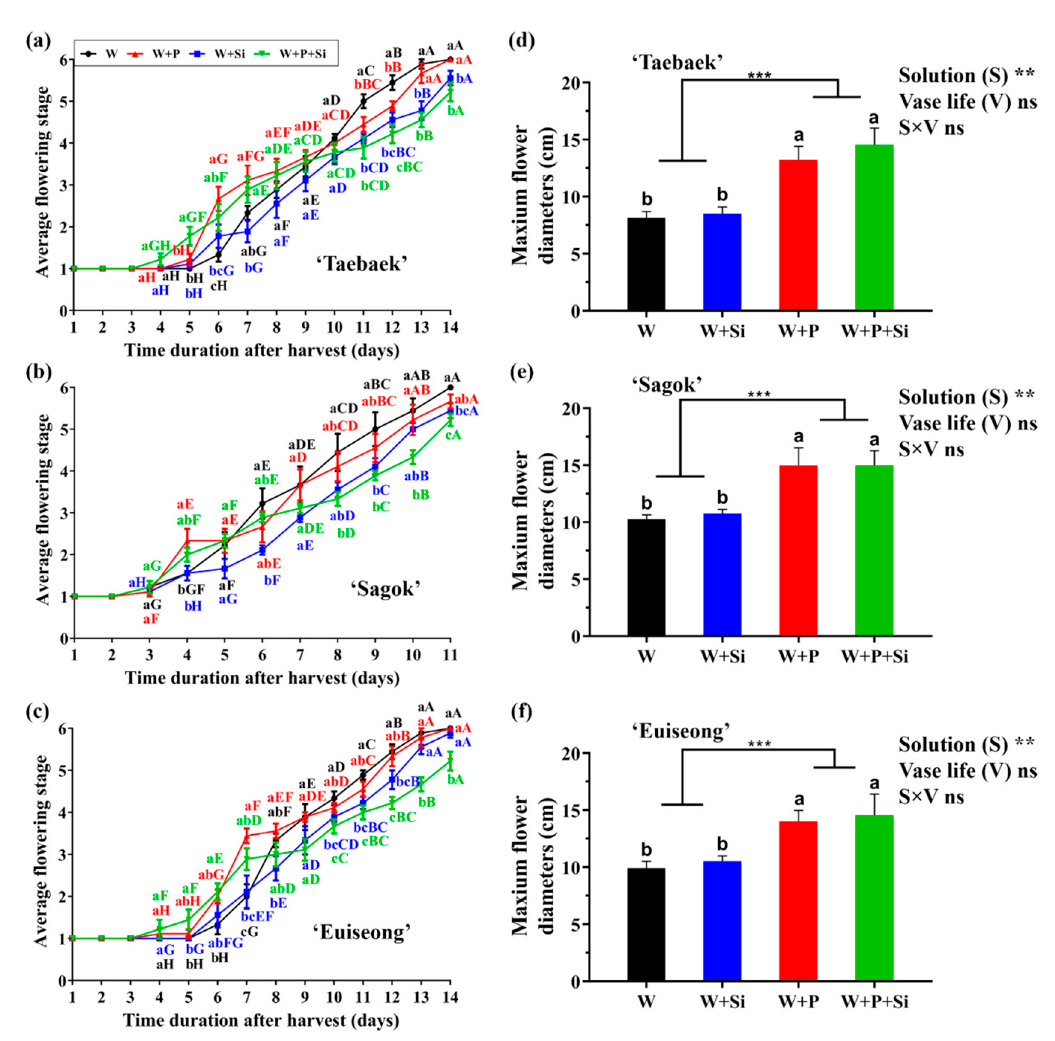
Figure 3. Effects of the four treatments on the vase life ( a – c ) and the maximum diameter ( d – f ) of cut peony flowers of three cultivars, namely ‘Taebaek’, ‘Sagok’, and ‘Euiseong’. Values are the average ± SE of n = 9 replicates. Different lowercase letters indicate the differences in flowering stages among treatments on the same day after harvest; different capital letters indicate the differences in flowering stages of same treatment on different days after harvest (one-way ANOVA with Duncan’s multiple comparison range test at p = 0.05); the significant differences between the P ( − ) and P (+) were determined following an unpaired two-tailed Student’s t test at p ˂ 0.001 (***), P( − ) was treated as the control group; interactive effects of solution treatments and longevity of vase life on the maximum flower diameters are shown by ** ( p ˂ 0.01) and ns determined by F -test. ‘W’: distilled water; ‘W + P’: distilled water supplemented with a preservative; ‘W+Si’: distilled water supplemented with silicon; ‘W + P + Si’: co-application of a preservative and silicon. Note that all the ‘W’, ‘W + P’, ‘W + Si’, and ‘W + P + Si’ appeared henceforth to carry the same meanings as mentioned here.